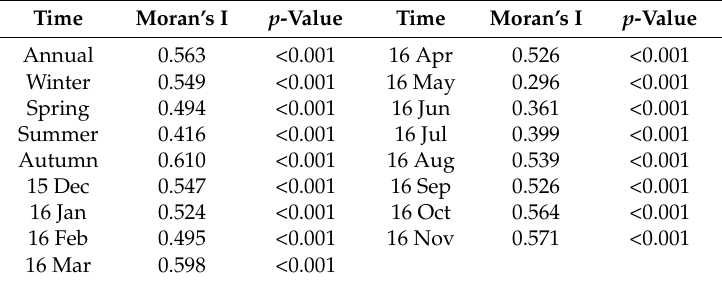
Table 4. Annual, Seasonal and monthly mean PM 2.5 Moran’s I.